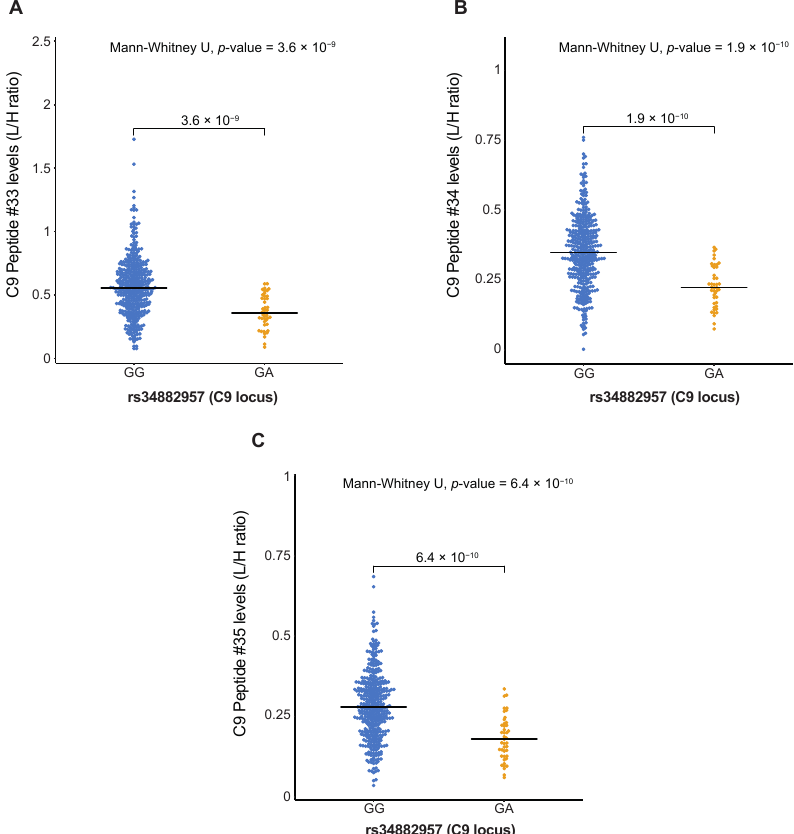
Figure 5. Complement C9 levels show significant differences between genotype groups of rare AMD risk variants at the C9 locus. Showing the distribution of peptide levels in light/heavy (L/H) in blood plasma for ( A ) peptide #33 (TSNFNAAISLK), ( B ) peptide #34 (VVEESELAR) and ( C ) peptide #35 (LSPIYNLVPVK), stratified by C9 p.Pro167Ser (rs34882957) genotype. Blue indicates homozygous AMD protective genotype, and yellow indicates the heterozygous